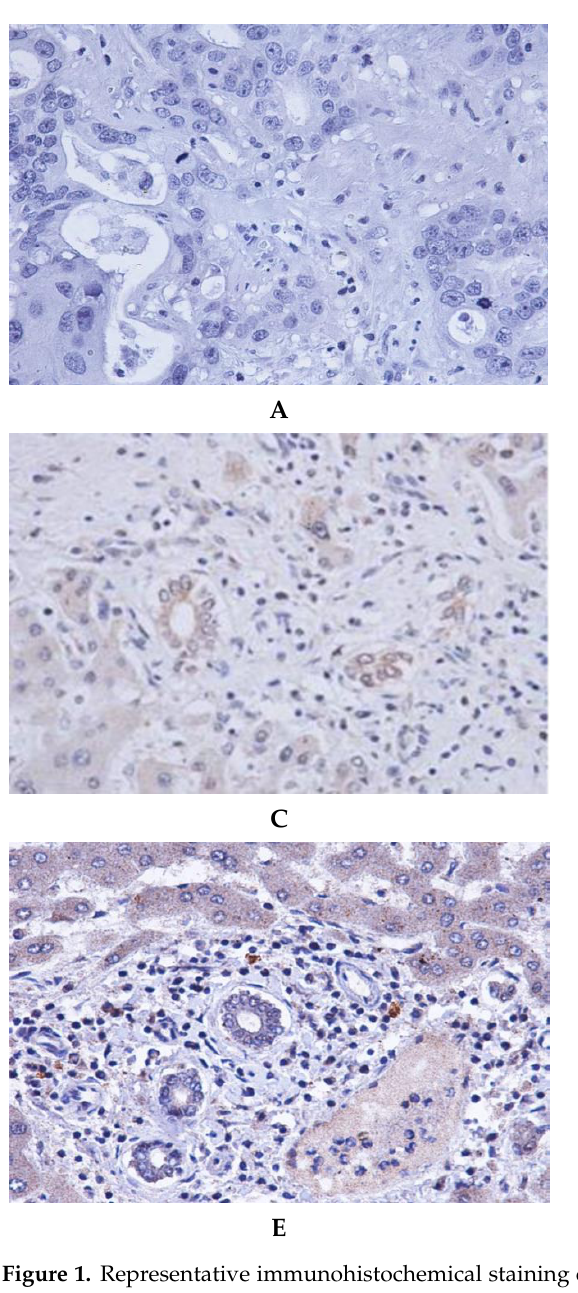
Figure 1. Representative immunohistochemical staining of CCDC25 and KLK11 in human CCA tissues (magnification, ×400). ( A , B ) Negative controls; ( C ) stained CCDC25 in adjacent non-cancerous tissue of a normal bile duct; ( D ) CCDC25 in CCA tumor cells; ( E ) stained KLK11 in adjacent non-cancerous tissue of a normal bile duct; ( F ) stained KLK11 in CCA tumor cells.